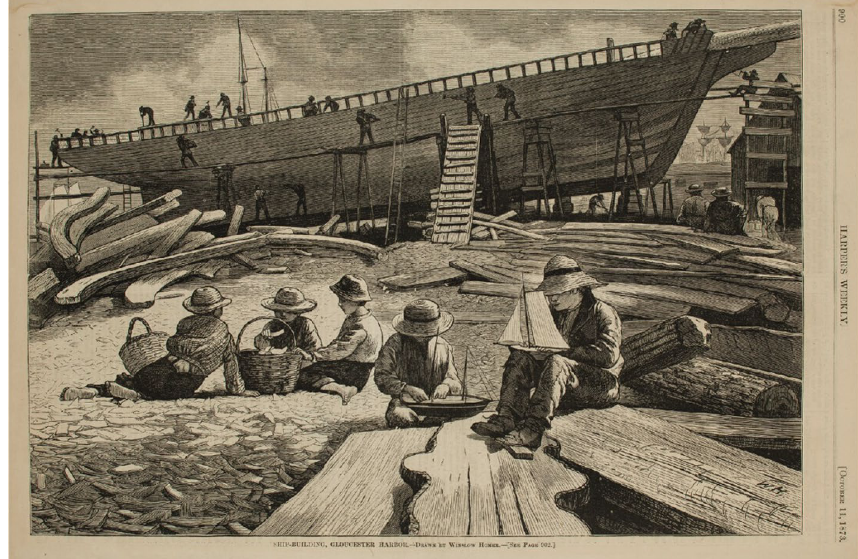
Fig. 2 Shipbuilding, Gloucester Harbor, 1873 (source: Wikimedia Commons, the image belongs to the public